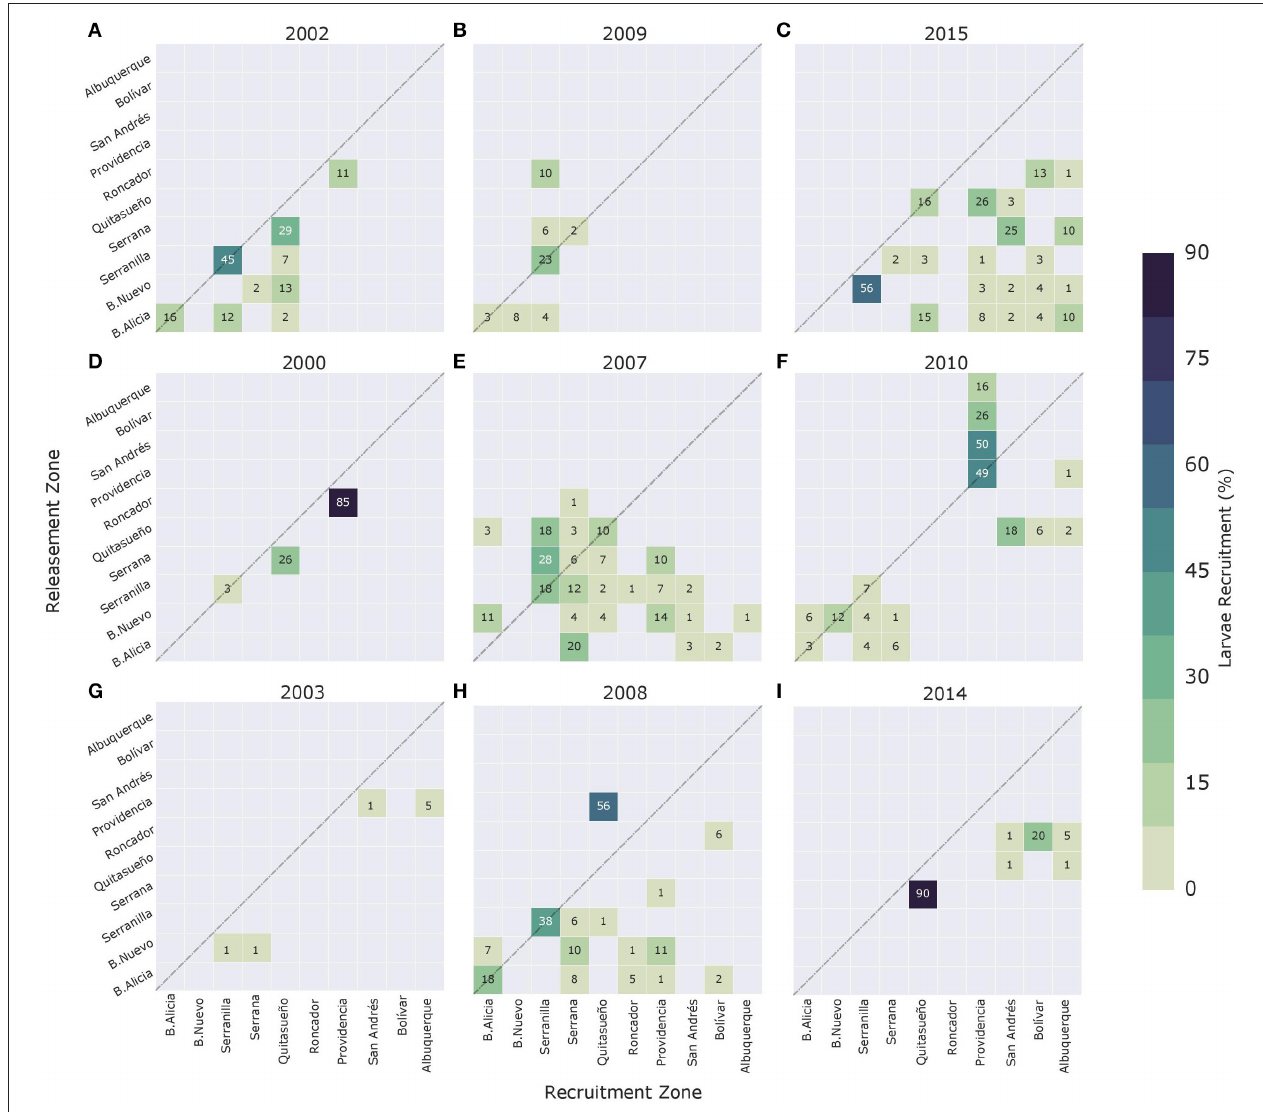
FIGURE 7 | Connectivity matrices for (A) 2002, (B) 2009, (C) 2015, (D) 2000, (E) 2007, (F) 2010, (G) 2003, (H) 2008, and (I) 2014 spawning events. Upper panels correspond to El Niño years, middle panels to La Niña years, and bottom panels to neutral ENSO condition years. Connectivity matrix shows the strength of each connection based on the amount received by reef j (x-axis) and contributed by reef i (y-axis). The diagonal of the matrix indicates reefs where local retention